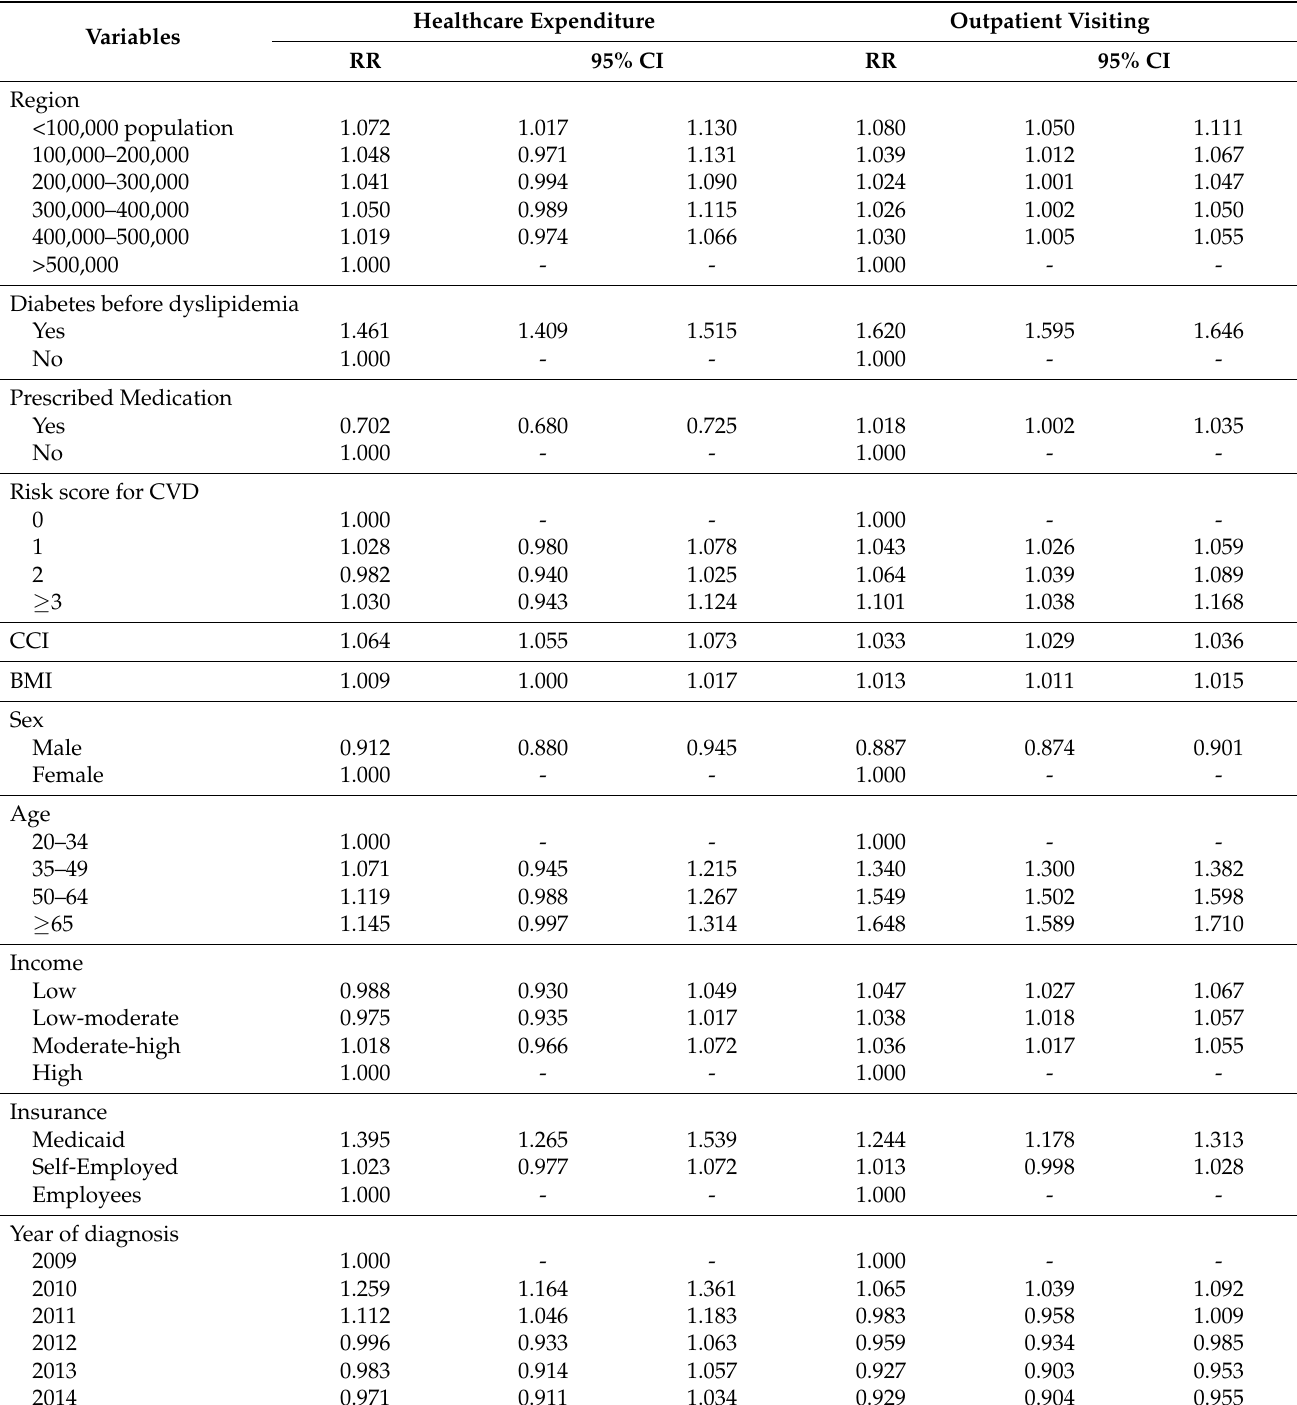
Table 3. The association between region and healthcare expenditure and outpatient